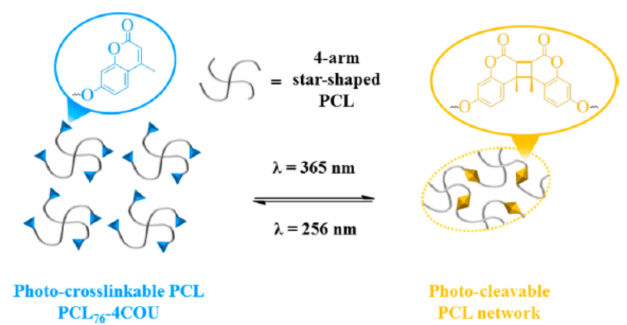
Figure 37. Schematic illustration of coumarin-based photocross-linkable star-shaped PCL for light- controlled design of network and shape reconfiguration. Reprinted with permission from [196]. Copyright (2019) American Chemical